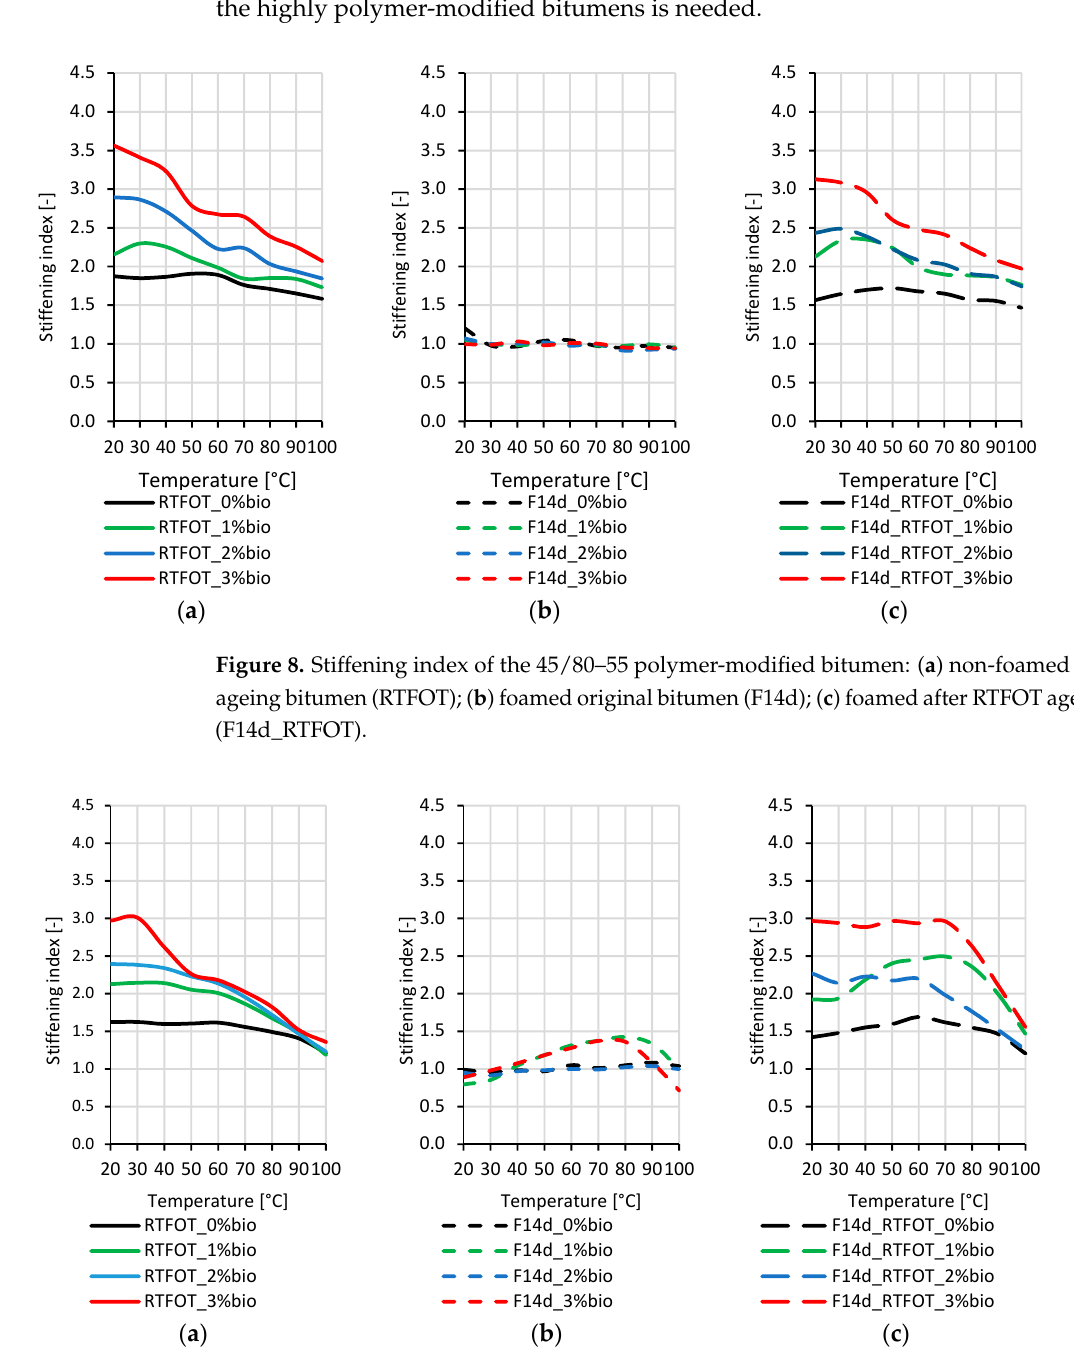
Figure 9. Stiffening index of the 45/80–80 highly modified bitumen: ( a ) non-foamed after RTFOT ageing bitumen (RTFOT); ( b ) foamed original bitumen (F14d); ( c ) foamed after RTFOT ageing bitumen